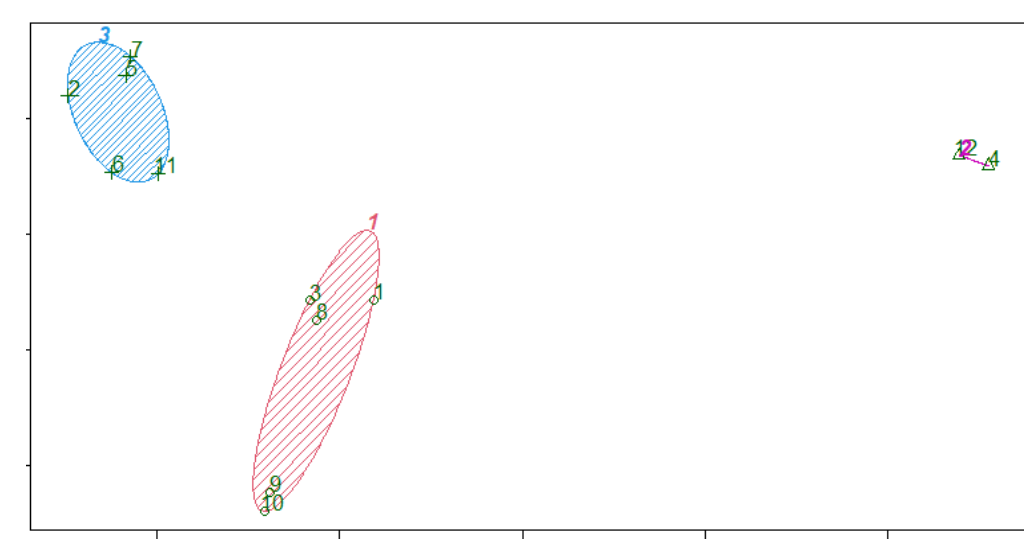
Figure 4. Results of applying the “gap_stat” method to the data.